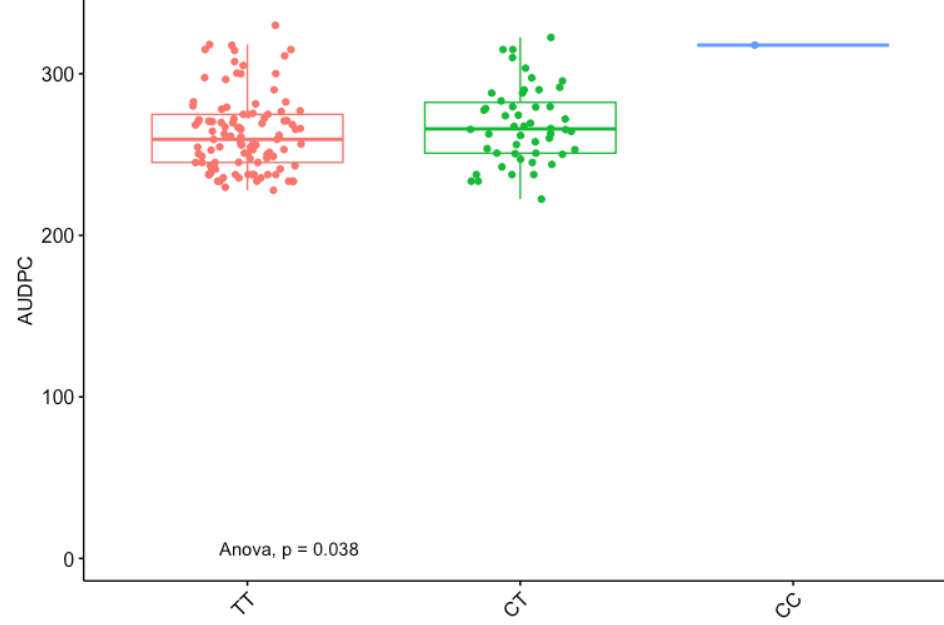
Figure 3. The boxplot showing the effect of the different alleles (variants) of Qyad-7-1 on the AUDPC values. The letters on the X-axis represent alleles (CC, CT, and TT).